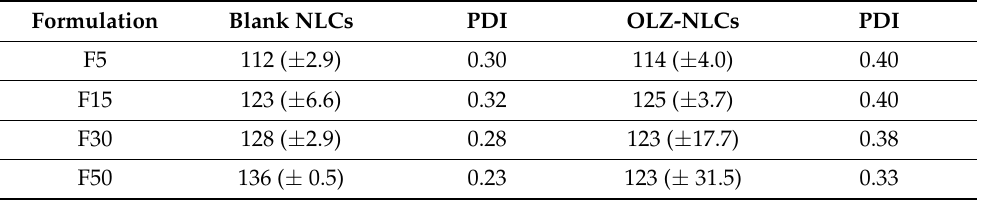
Table 3. Effect of solid to liquid lipid ratio on the particle size and PDI of blank and drug- loaded